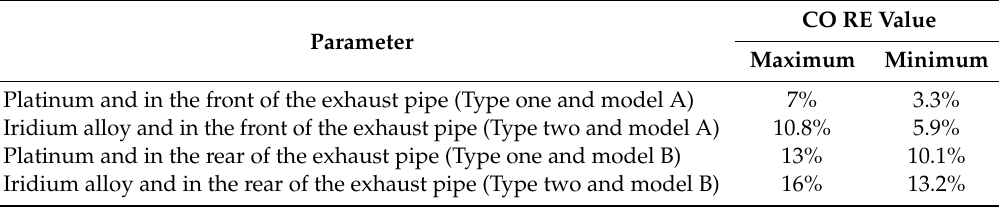
Figure 18. The CO RE at control voltage 5 V. Table 7. The maximum and minimum values of CO removal efficiency at control voltage 5 V.